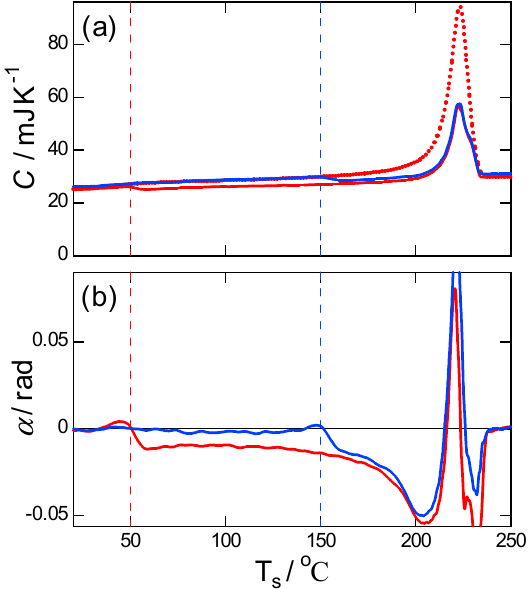
Figure 8. T-M DSC results of ( a ) magnitude and ( b ) phase angle during heating after cold crystalliza- tion from the glass at T c = 50 ◦ C for 1 min and annealing at T a = NA, 150 ◦ C for 1 min. P = 80 s and β = 3 K min − 1 in the heating-only mode. The dotted line in ( a ) represents − HF/ β for the case without annealing. Vertical broken lines represent respective treating temperatures.